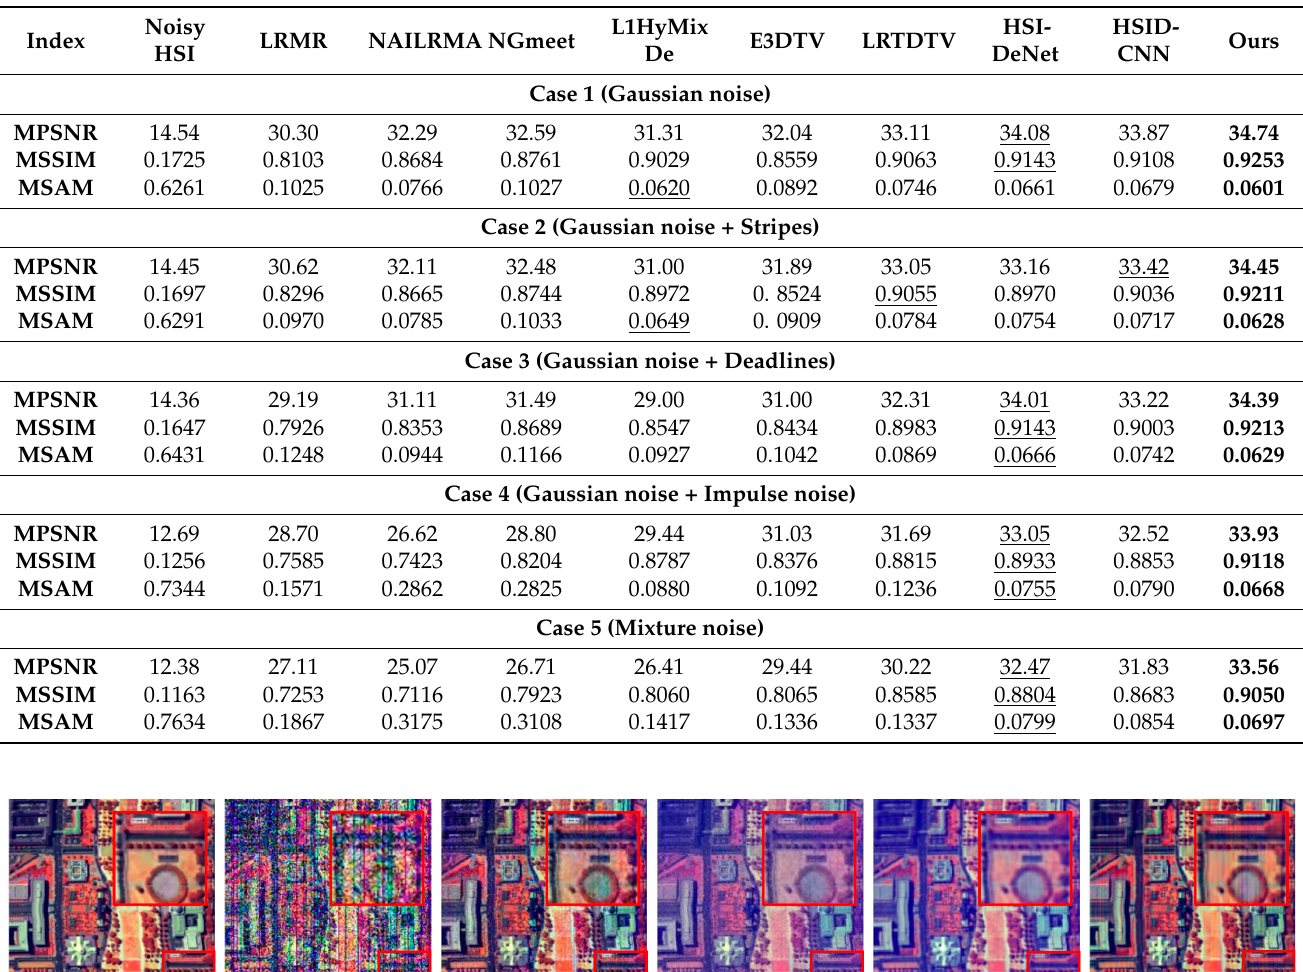
Table 2. Quantitative assessment of different algorithms applied to Washington DC Mall data with mixture noise cases.